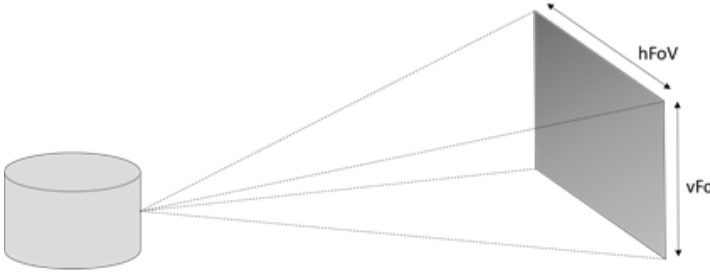
Figure 3. LiDAR horizontal and vertical FoV.